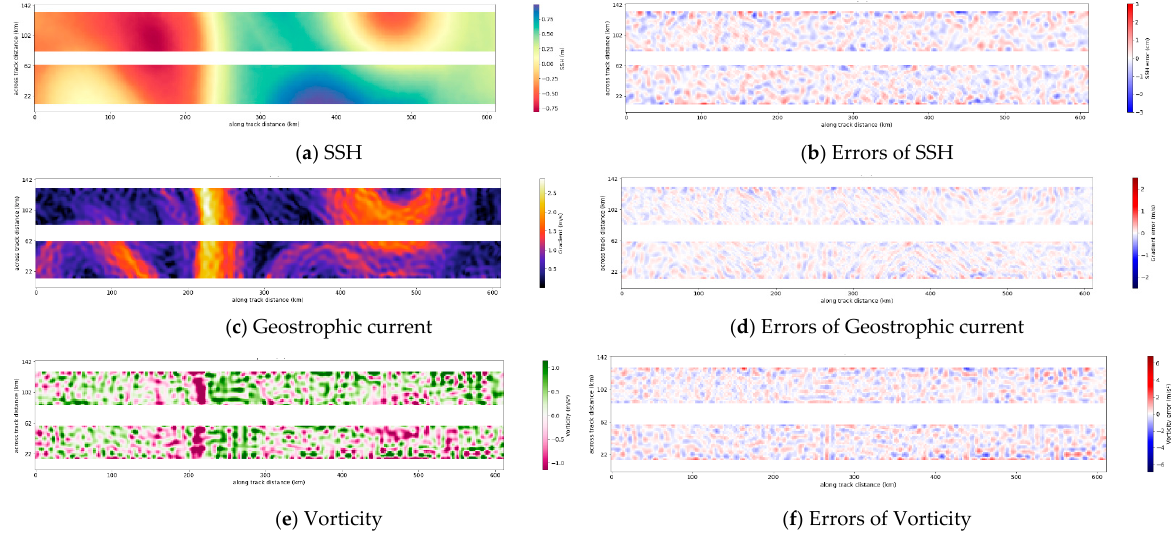
Figure A2. SSH denoised by the Lanczos smoother and its derivatives in the left column. The associated errors are plotted in the right columns. The ground truth of the SSH, the geostrophic current and the vorticity are in Figures 3–5, respectively (Pass 496, cycle 17 located in the Gulf Stream).